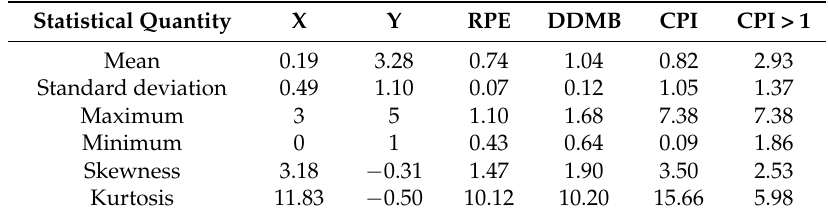
Table 4. Descriptive statistical summary of soil pollution comprehensive assessments.